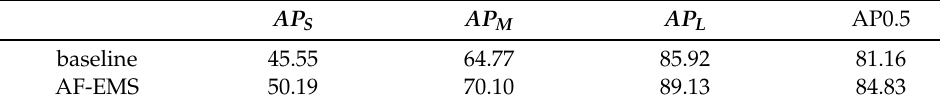
Table 7. Detection result on COCO dataset.